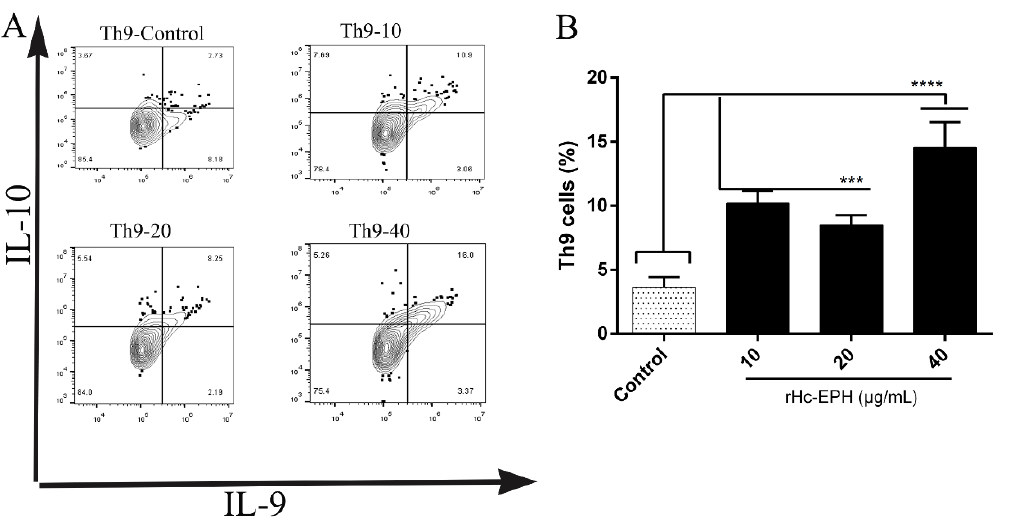
Figure 8. Measurement of rHcEPH on Th9 cells differentiation by flow cytometry. The plots shown are gated on CD2 + CD4 + T cells and using representative intracellular cytokine antibodies (IL-9 and IL-10). ( A ): Contour plots analysis and proportion of PBMCs derived-Th9 cells treated with serial concentrations of rHcEPH and PBS; ( B ): Percentage of differentiation of Th9 cells after rHcEPH treatment. The data is denoted as mean ± SEM of triplicate independent experiments (*** p < 0.001, **** p < 0.0001).